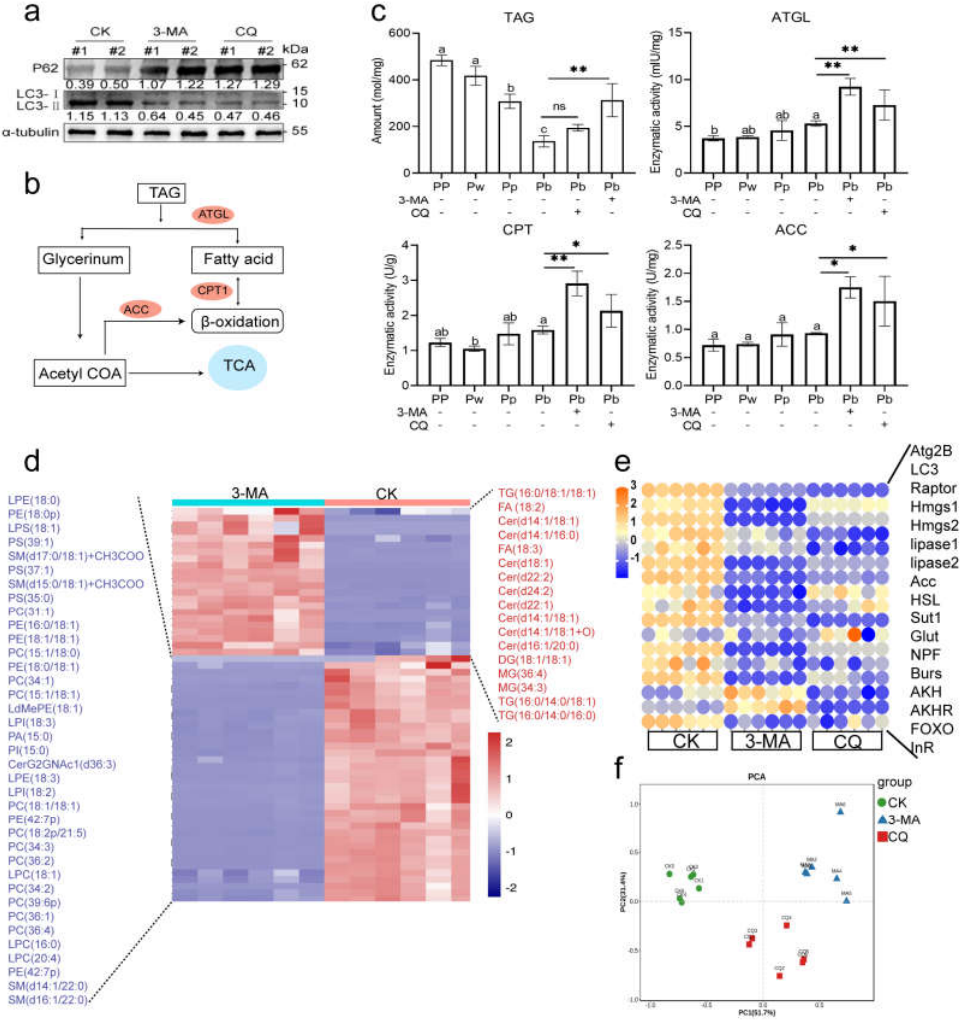
Figure 2. Effects of autophagy inhibitors (3−MA and CQ) on lipid metabolism during pupal stage in Apis mellifera. ( a ) Western blot images showing levels of autophagy indicator proteins (LC3 and P62) in Pw with the autophagy inhibitors (3−MA and CQ) treatment. ( b ) Schematic of TG lipolysis for β−oxidation. ( c ) Determination of TAG content and rate-limiting enzymes in TAG lipolysis for β−oxidation both in stage PP, Pw, and Pb and under the treatment of autophagy inhibitors (3−MA and CQ) in Pb. ( d ) Heatmap showing the differential lipid metabolites between group 3−MA and CK. ( e ) qRT−PCR analysis of expression of genes involved in lipid metabolism and related activities. ( f ) Principal component analysis plot of qRT−PCR data in 3−MA, CQ and CK. Note: Data are shown as mean ± SEM and the different letters or * marked on the bar chart represent significant differences ( p < 0.05), ** ( p < 0.01), ns, non-significant ( p > 0.05).